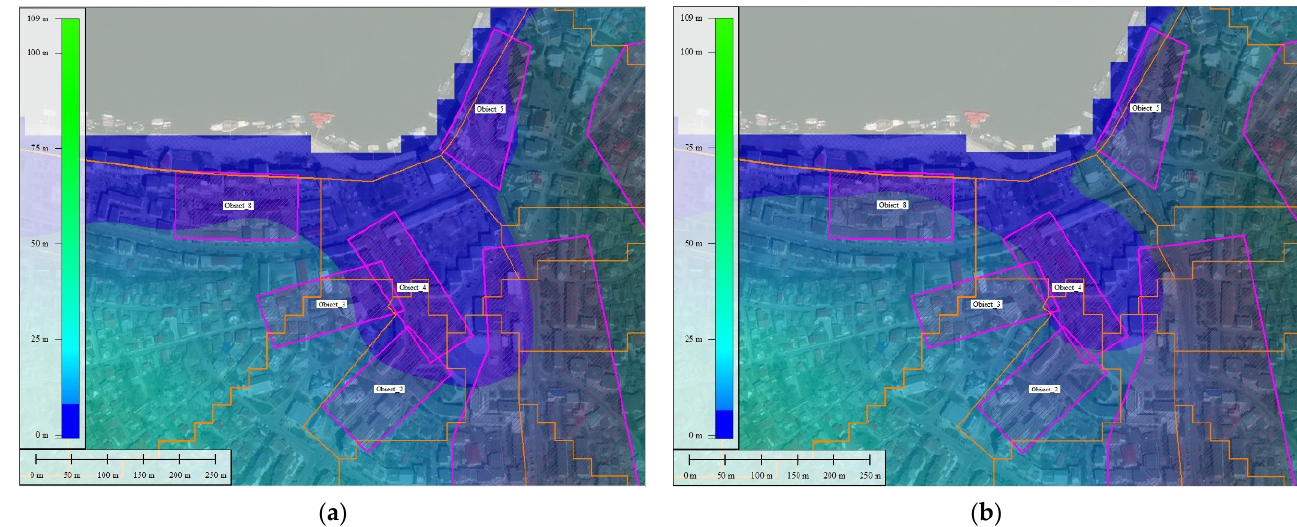
Figure 19. The flooded areas derived for the 2013 event: ( a ) Hypothesis 1 and ( b ) Hypothesis 2.